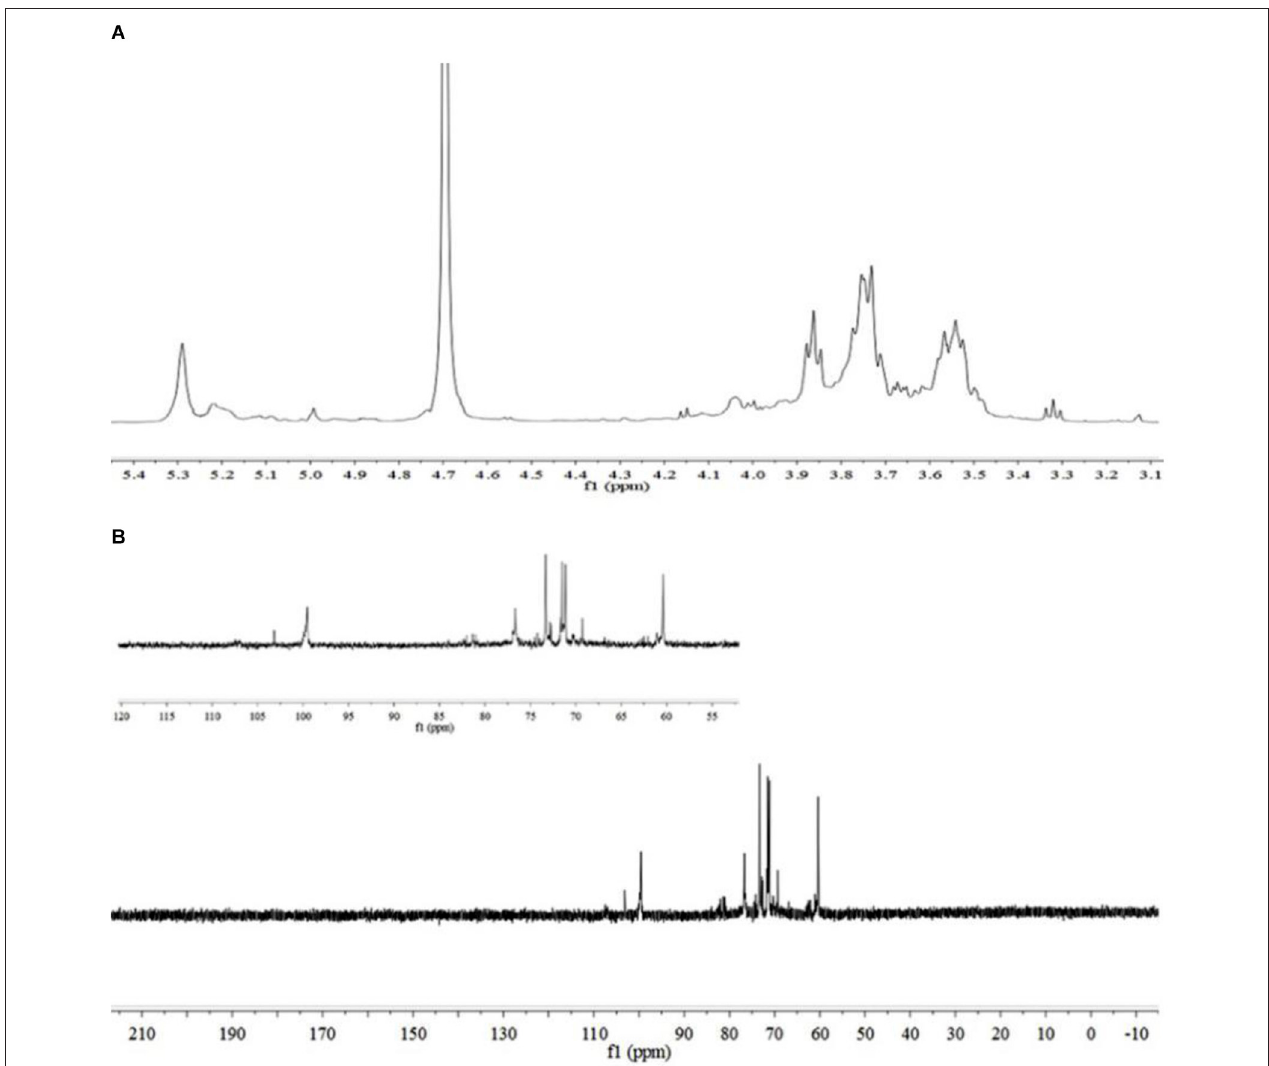
FIGURE 2 | NMR spectra of MDP. (A) 1 H NMR spectrum of MDP and (B) 13 C NMR spectrum of